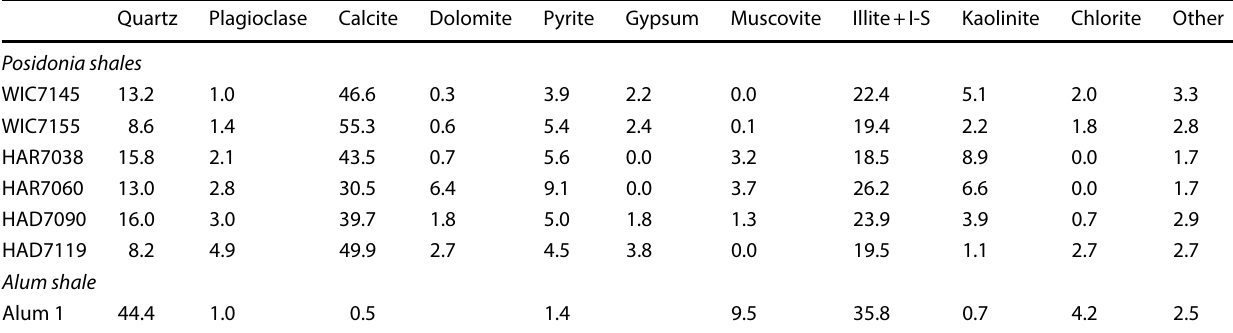
Table 2 Mineral composition of Posidonia and alum shales in wt%